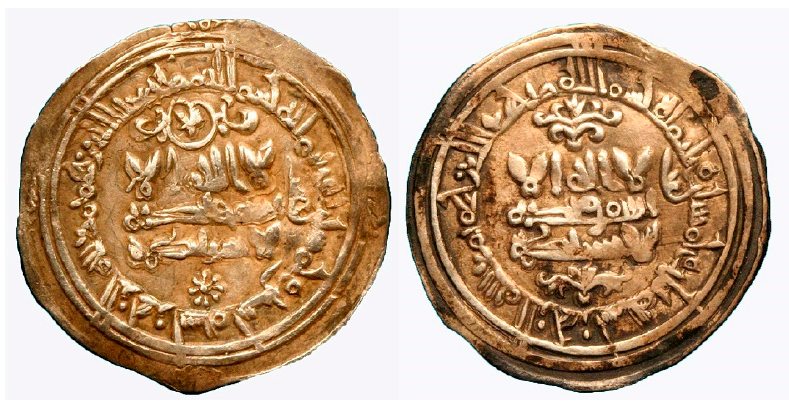
Figure 16. Dirhams of al- Ḥ akam II: 963-964/352H (MANF2008_103_85_P) and 964-965/353 H (MANF2008_103_129_P) coined at the mint of Madinat al-Zahra’. Museo Arqueológico Nacional, Madrid. Photo: María del Mar Gómez Talavera, © In public domain.